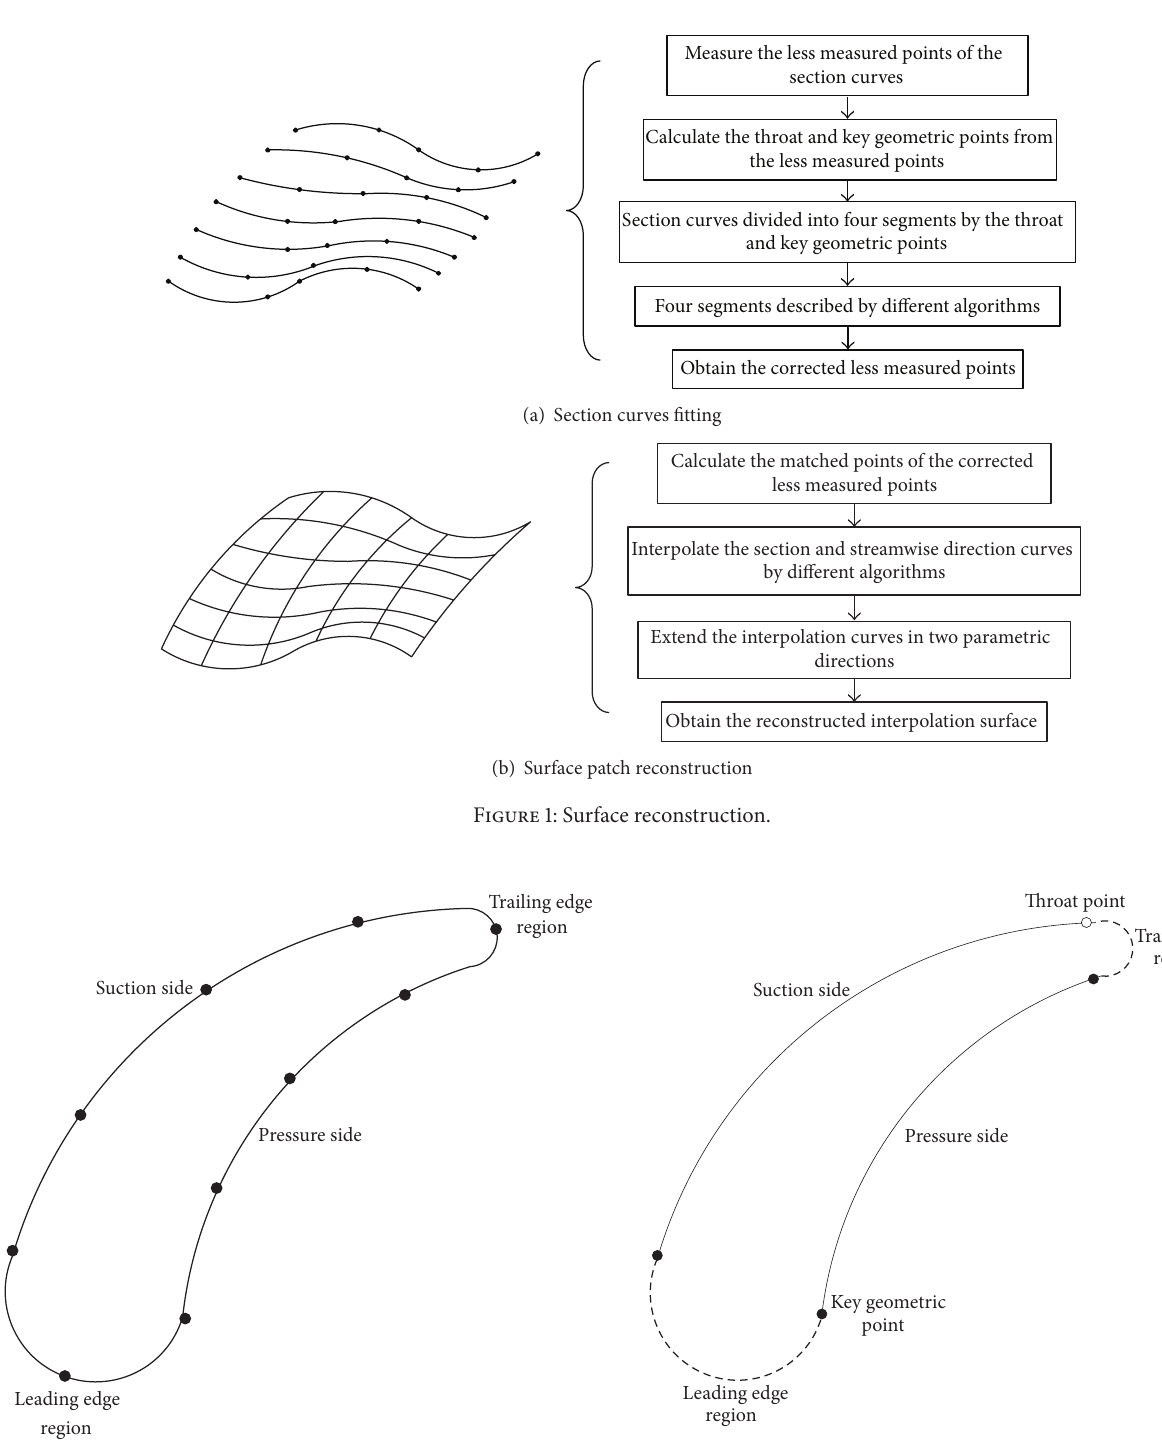
Figure 3: Section curve